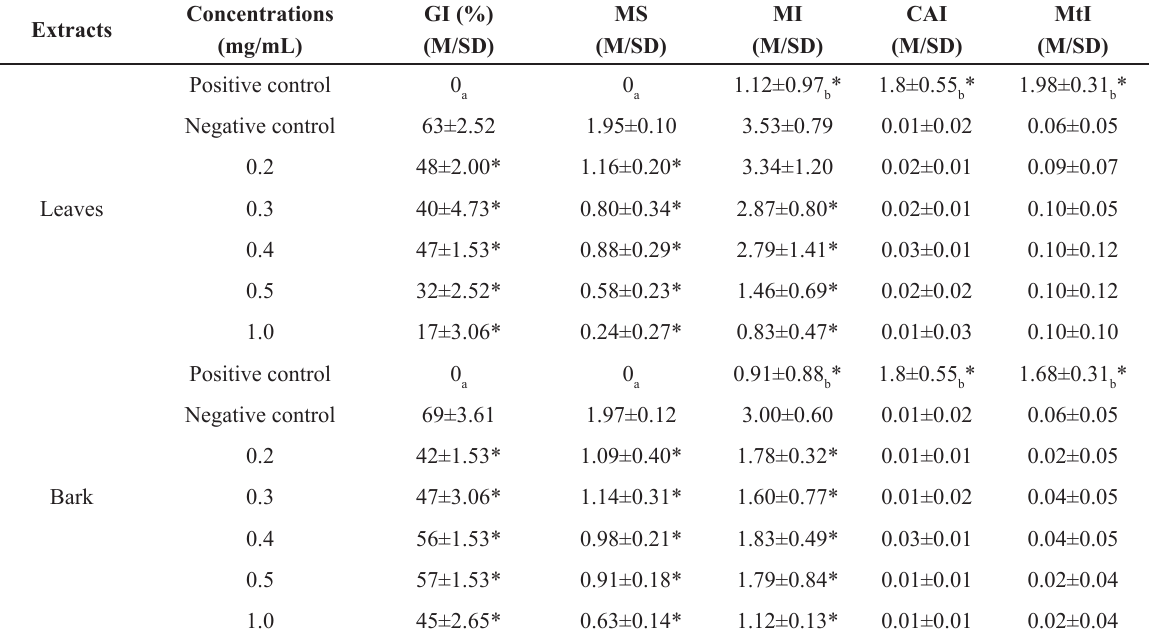
Germination index (GI) of seeds, medium-sized root (MS), mitotic index (MI), chromosomal alterations index (CAI), and mutagenicity index (MtI) for A. cepa after treatment with different concentrations of ethanol bark extracts and ethanol leaves extracts of M. urundeuva